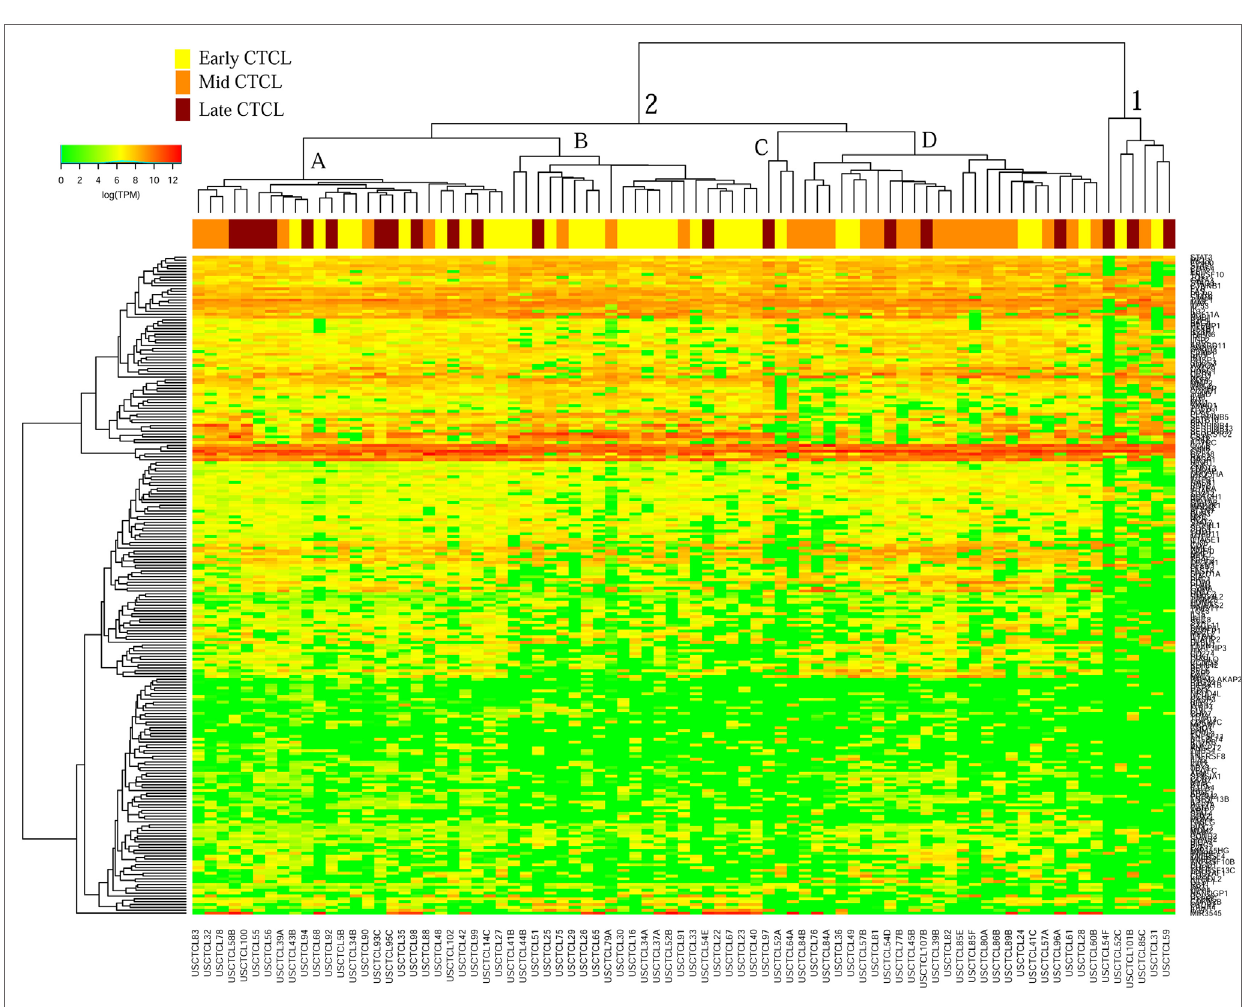
FigUre 6 | Unsupervised hierarchical clustering analysis based on TruSeq targeted RNA gene expression analysis of 284 select genes in ≥ 2009 early-stage (stage ≤ IIA, yellow), mid-stage (stages IIB and III, orange), and late-stage (stage IV, dark red) formalin-fixed paraffin-embedded cutaneous T-cell lymphoma (CTCL) samples. A color key refers to gene expression in log(transcripts per million).